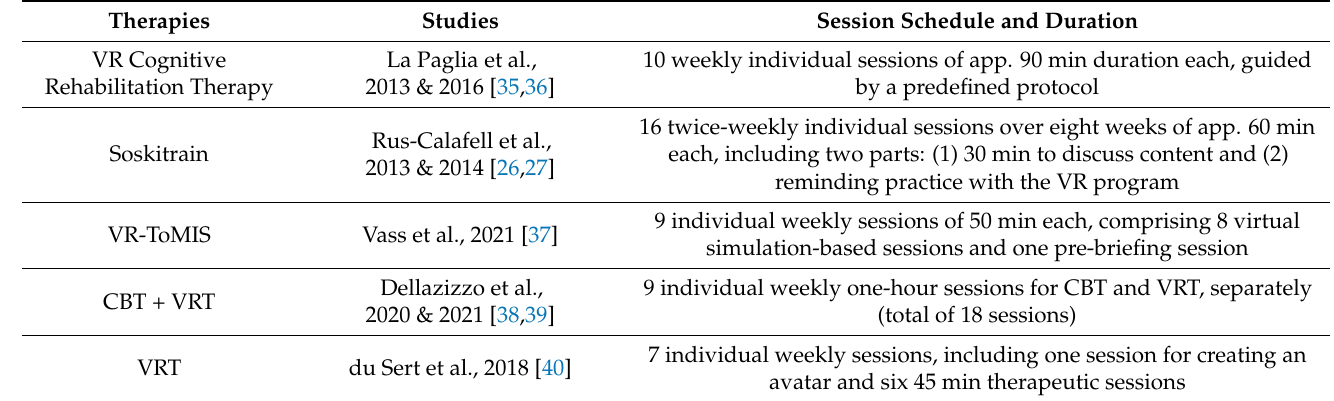
Table 2. Schedule and duration of different VR-based interventions for psychotic